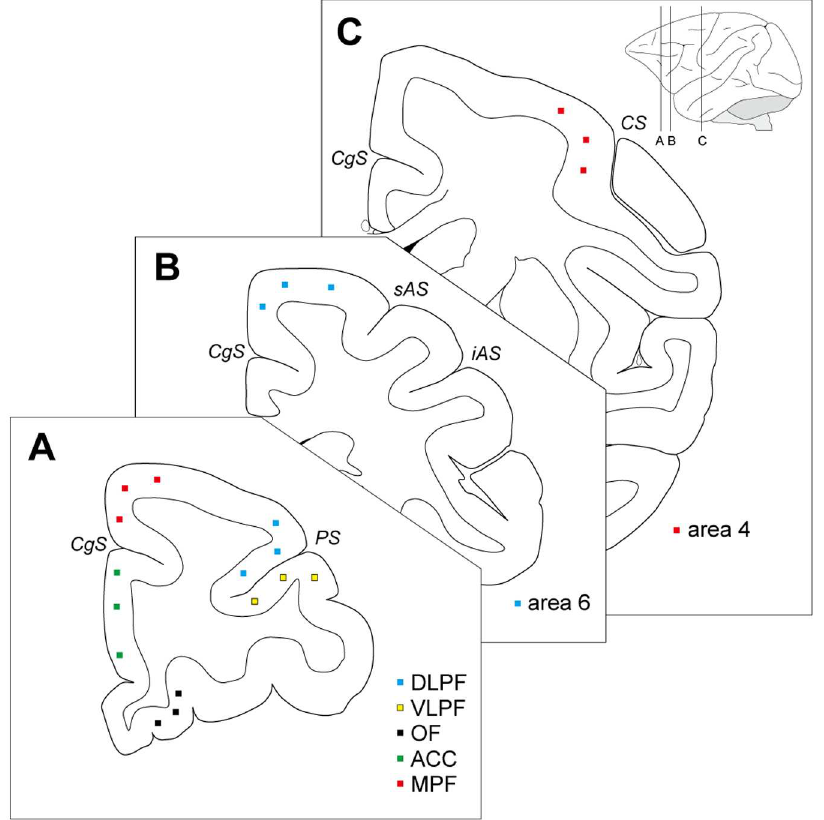
A-C. The rostrocaudal levels of the sections are indicatedat the top-right corner. Modifiedfrom “The Rhesus Monkey Brain in Stereotaxic Coordinates” [27]. ACC, anterior cingulatecortex; CgS, cingulatesulcus; CS, central sulcus; DLPF, dorsolateralprefrontalcortex; iAS, inferior limb of the arcuate sulcus; MPF, medial prefrontalcortex; OF, orbitofrontal cortex; PS, principal sulcus; sAS, superiorlimb of the arcuate sulcus; VLPF, ventrolateral